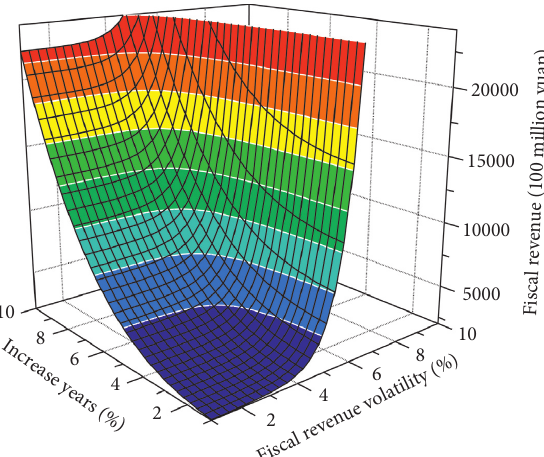
Figure 6: Forecast function of local fiscal revenue.